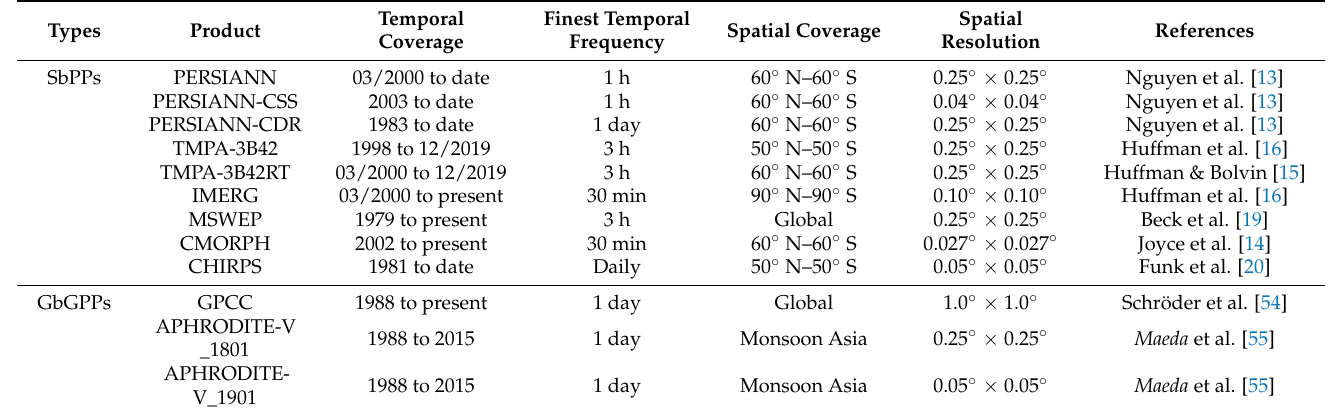
Table 1. Description of the precipitation